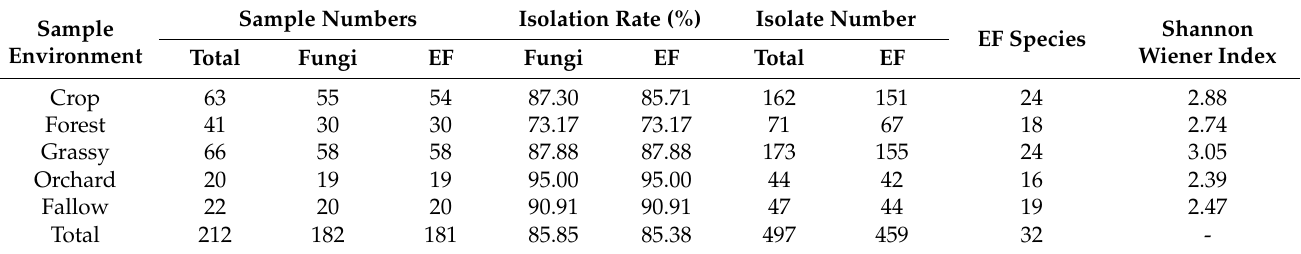
Table 3. The fungi isolation and biodiversity of different